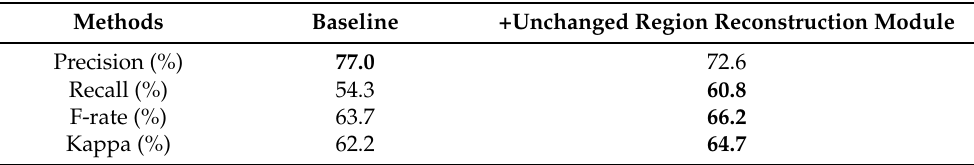
Table 3. The results of the unchanged region reconstruction module.